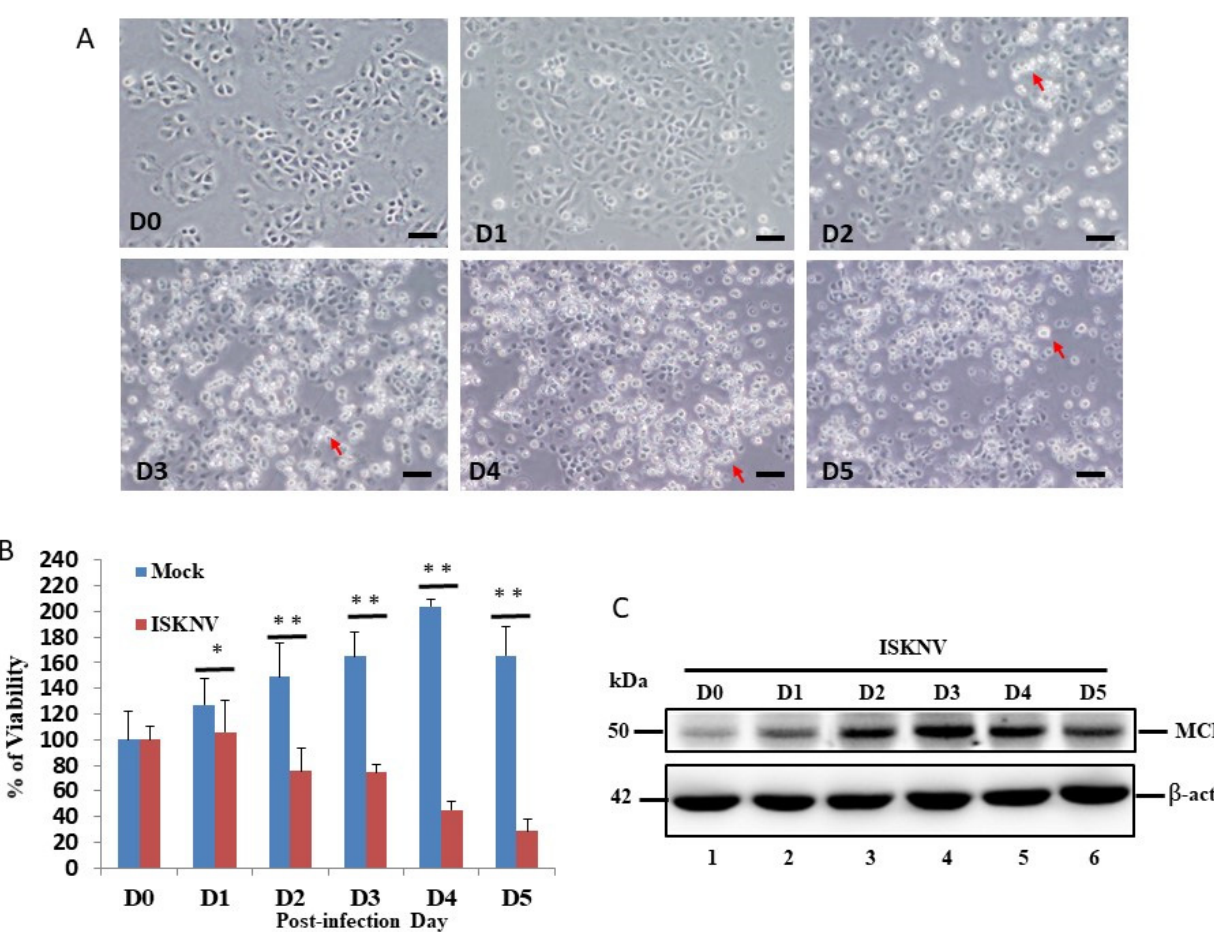
Figure 1. ISKNV infection and expression directly induces cell death in GF-1 cells. ( A ) Phase-contrast micrographs of ISKNV-infected GF-1 cells at different time points (D0-D5). Phase-contrast images in which rounded-up cells are indicated by red arrows. Scale bar=20 µm. ( B ) The percentage of cell viability of ISKNV-infected cells at different time points. The numbers of virus-infected cells in each 200 cell sample were assessed in three individual experiments. Each point repre- sents the mean ISKNV-infected cells of three independent experiments ± the standard error of the mean (SEM). The data were analyzed using either paired or unpaired Student’s t -tests, as appropriate. Statistical significance was defined as * p - values < 0.05; ** p -values < 0.01. ( C ) Western blot analysis of ISKNV major capsid protein (MCP) expression in GF-1 cells following transfection and incubation for D0 (lane 1), D1 (lane 2), D2 (lane 3), D3 (lane 4), D4 (lane 5), and D5 (lane 6). MCP proteins were detected by Western blot analysis; the gels were immunoblotted with a polyclonal antibody to ISKNV MCP and ß-actin as an internal